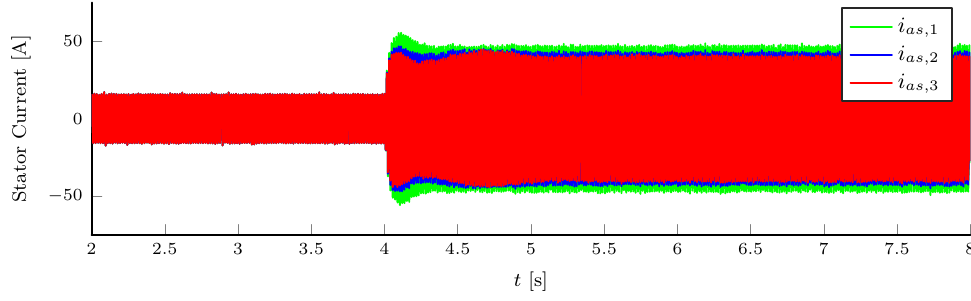
Figure 22. Phase a stator currents; current-source control. In Figure 22, a phase stator currents are shown for all motors. After t = 4 s, the motor − currents display different peak currents; these differences correspond to the application of unequal load torques.